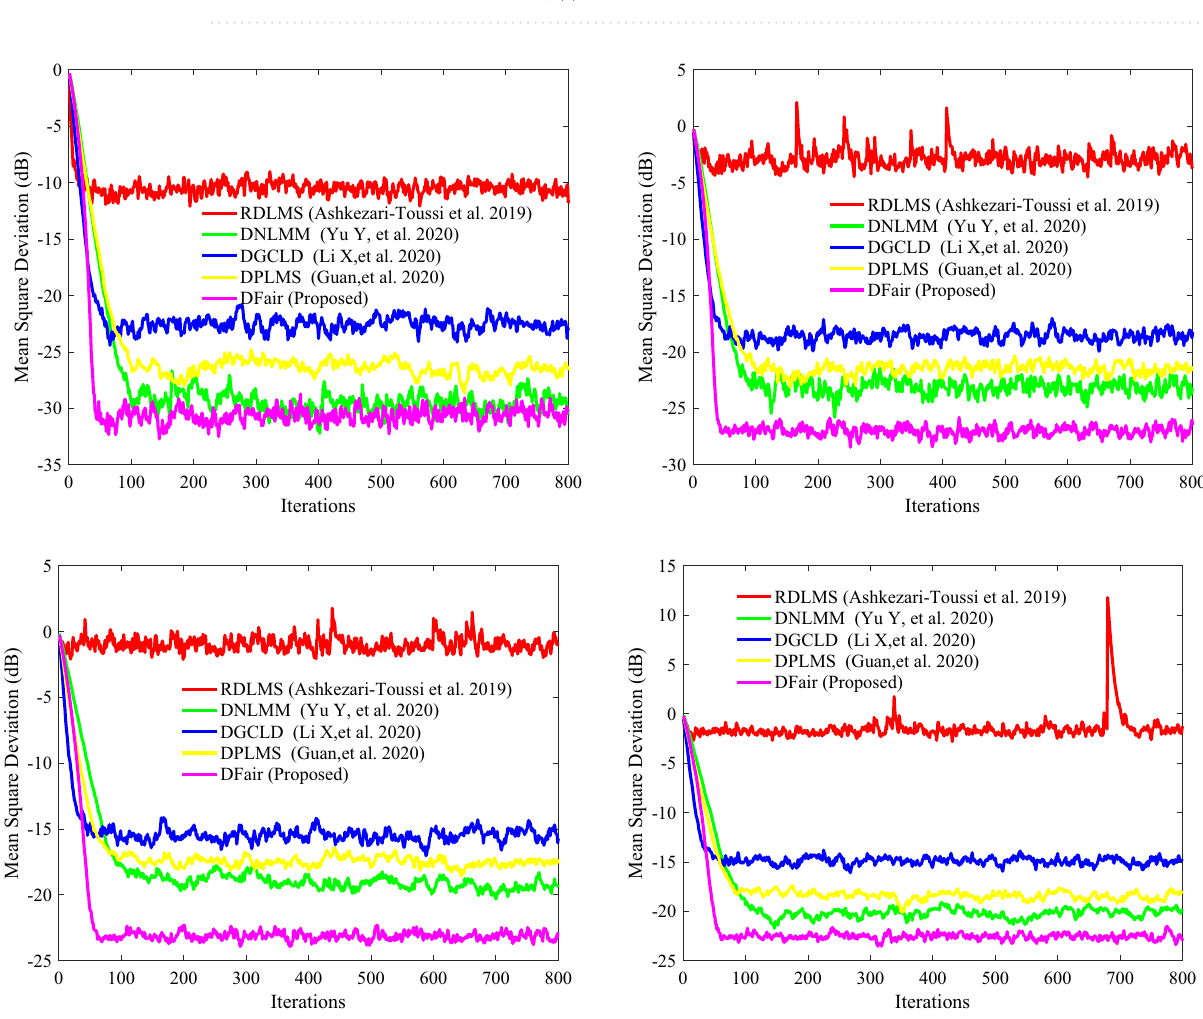
Figure 12. Transient network MSD (dB) iteration curves of the RDLMS, DNLMM, DGCLD, DPLMS, and DFair algorithms. (Up_Left) with Pr = 0.1 , (Up_right) with Pr = 0.2 , and (Down_left) with Pr = 0.4 , and (Down_Right) with Pr = 0.6